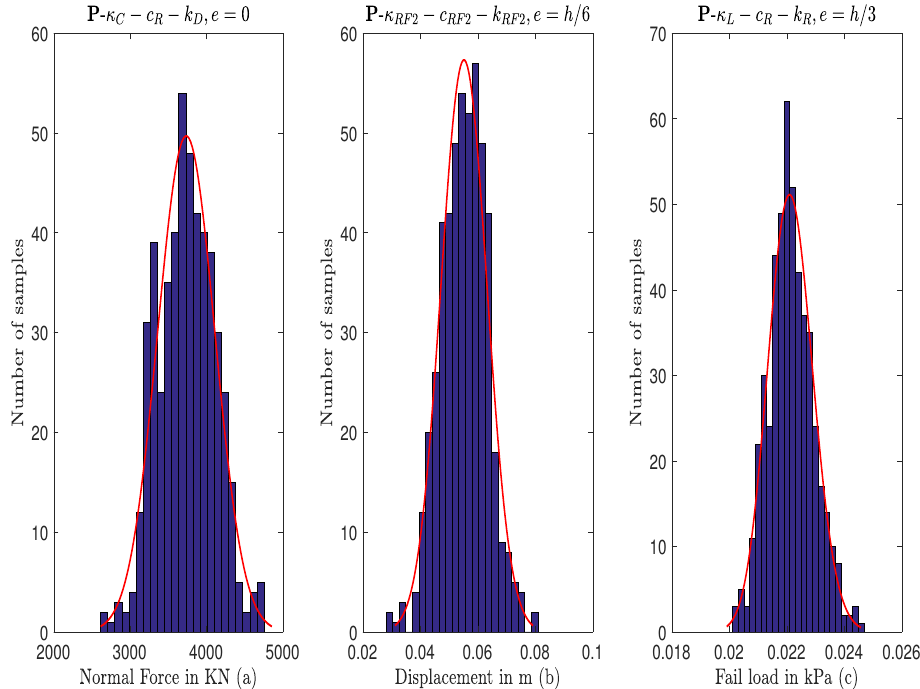
Figure A7. Histograms of monitored output variables and the normal distribution fitting for 3 randomly selected analyses. ( a ) Porous analysis with constant distribution for κ , random distribution for c and k with e = 0 and monitored output variable the Normal force; ( b ) porous analysis of eccentricity e = h with random field representations for all stochastic material variables and b = 2 6 m and monitored output variables of the maximum failure displacement. ( c ) Porous analysis with linear distribution for κ , random distribution for c and k with e = h and monitored output variable 3 the maximum settlement stress in